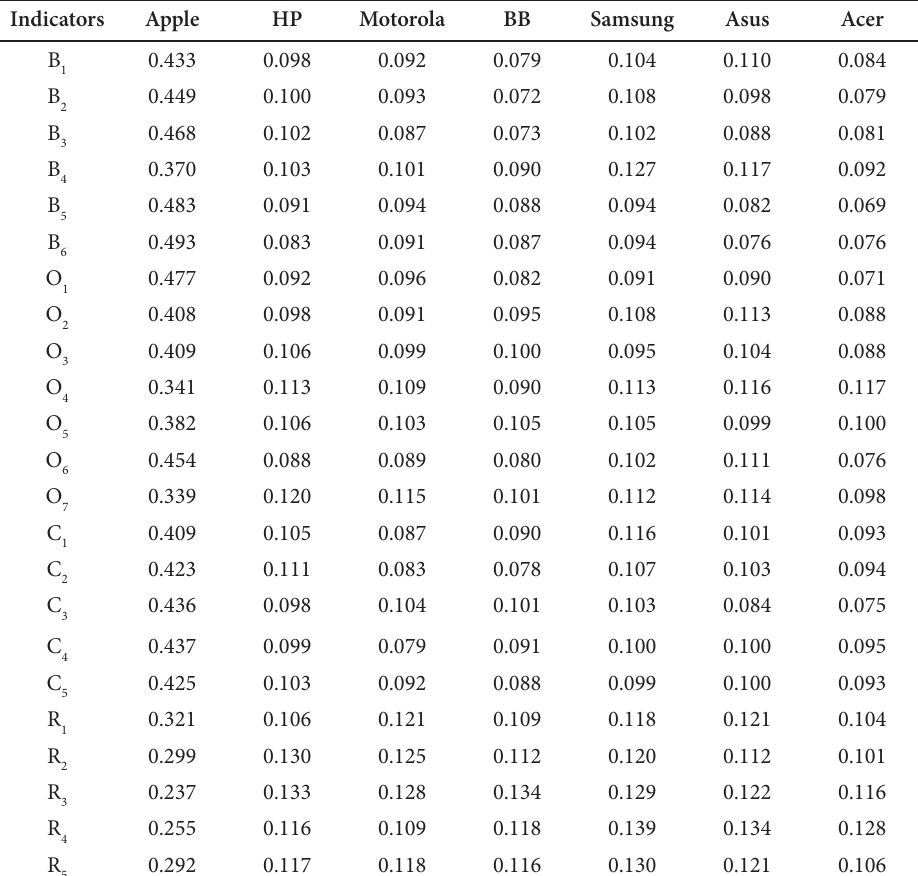
Table 3. Weights of tablet PCs evaluation with respect to sub-criteria (decision matrix)